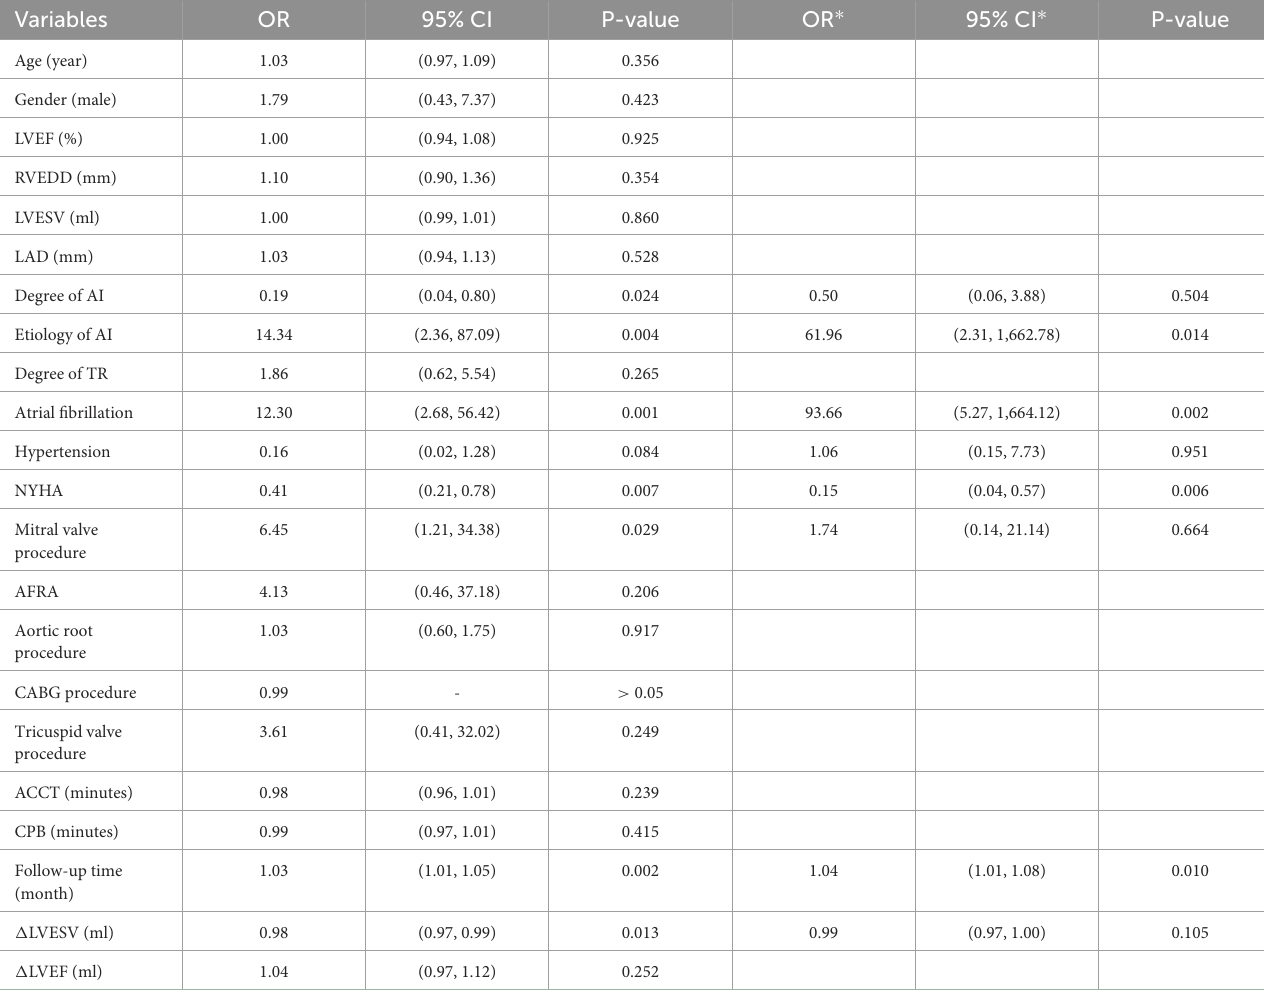
TABLE 3 Logistic regression analysis for deterioration of mitral regurgitation during the follow-up. Variables